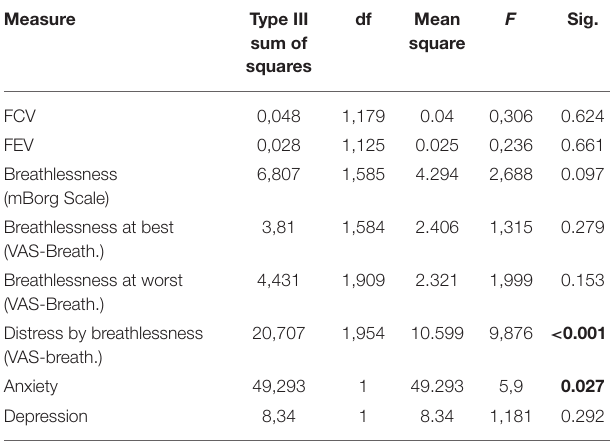
Breathlessness at worst (VAS-breath.)